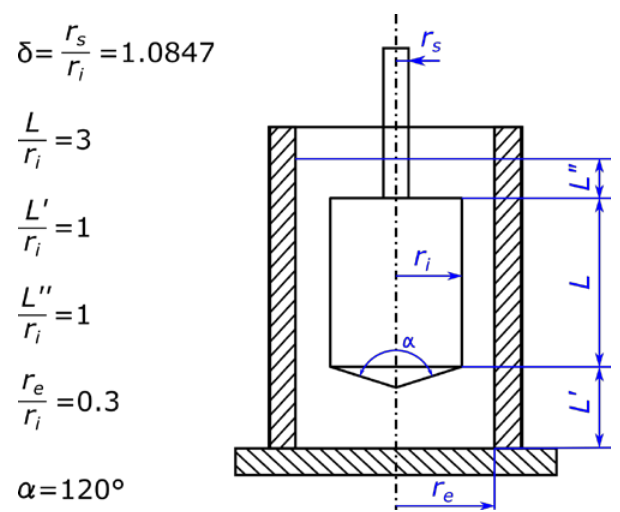
Figure 1. The Concentric Cylinder (Couette) geometry and the geometry parameters according to the ISO 3219 Standard.